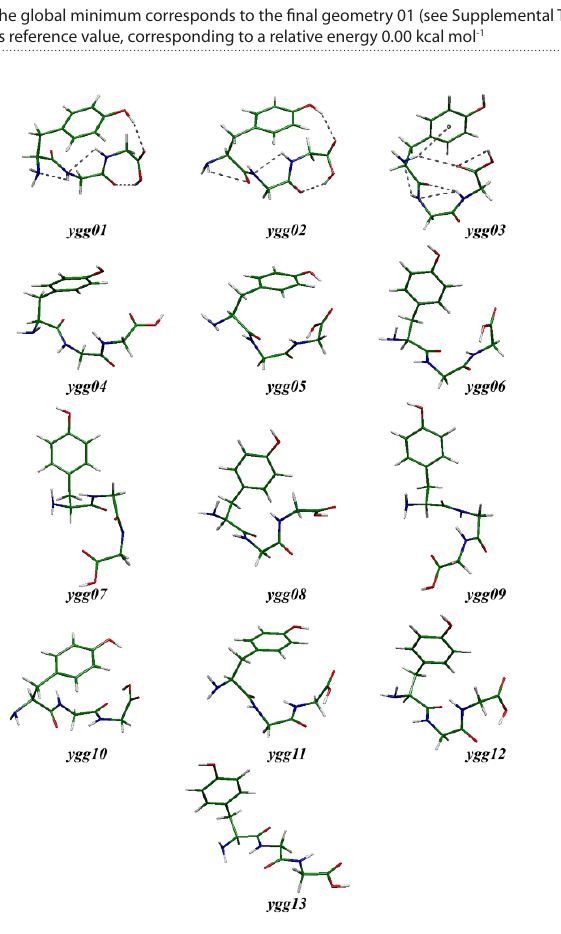
Figure 2. RHF/6-31G(d) geometries for the 13 most stable structures of YGG tripeptide. Intramolecular H-bonds are also shown for the three most stable